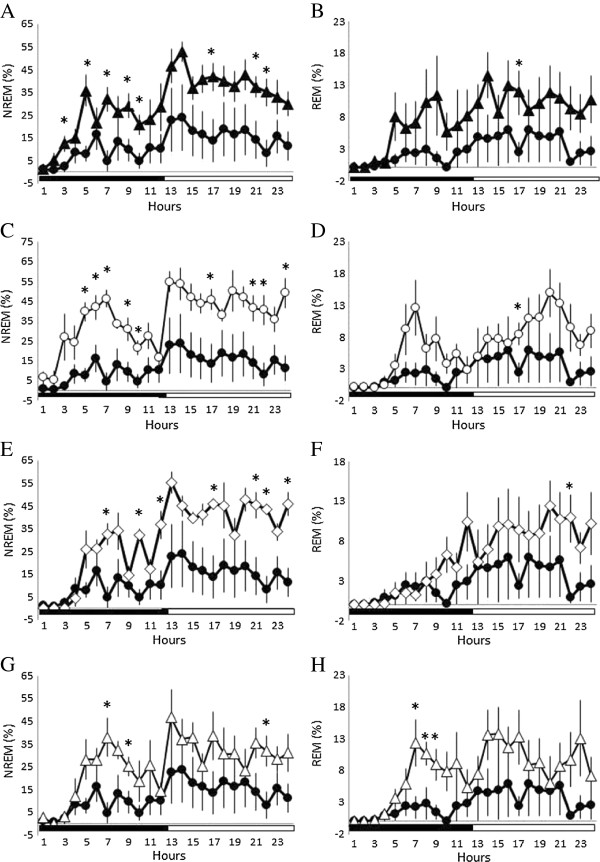
The effects of naloxone, naloxonazine, naltrindole and nor-binaltorphimine on the EA-induced exacerbation of sleep disruptions in rats with focal epilepsy. Panels A &B: the effects of naloxone on EA-induced disruptions of NREM sleep and REM sleep. Panels C &D: the effects of naloxonazine on EA-induced disturbances of NREM sleep and REM sleep. Panels E &F: the effects of naltrindole on EA-induced disruptions of NREM sleep and REM sleep. Panels G &H: the effects of nor-binaltorphimine on EA-induced disturbances of NREM sleep and REM sleep. Black circles: the data obtained from the PFS + EA + pilocarpine group; black triangles: the values acquired from the naloxone + EA + pilocarpine group; open circles: the results obtained from the naloxonazine + EA + pilocarpine group; open diamonds: the data acquired from the naltrindole + EA + pilocarpine group; open triangles: the values obtained from the nor-binaltorphimine + EA + pilocarpine group. *: p < 0.05 vs. the values obtained from the PFS + EA + pilocarpine group. Black bar: the dark period; white bar: the light period.